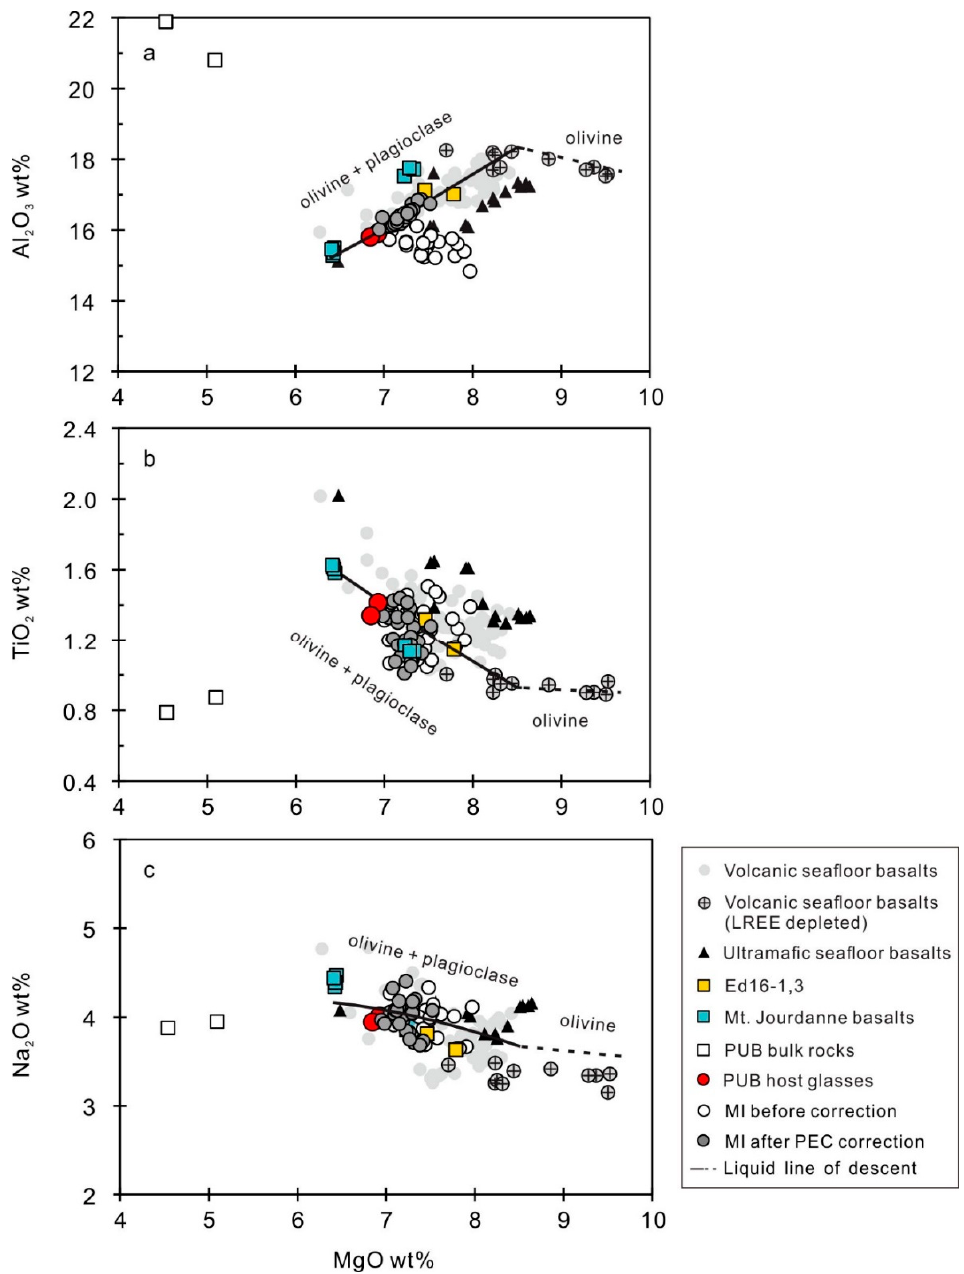
Figure 5. ( a ) Al 2 O 3 , ( b ) TiO 2 and ( c ) Na 2 O versus MgO variation diagrams of melt inclusion compositions before and after post-entrapment crystallization correction—Mount Jourdanne basalts, PUB bulk rocks and host glasses. Also shown are the 61–67° E basalts [30] and liquid line of descent (calculated with Petrolog 3 software